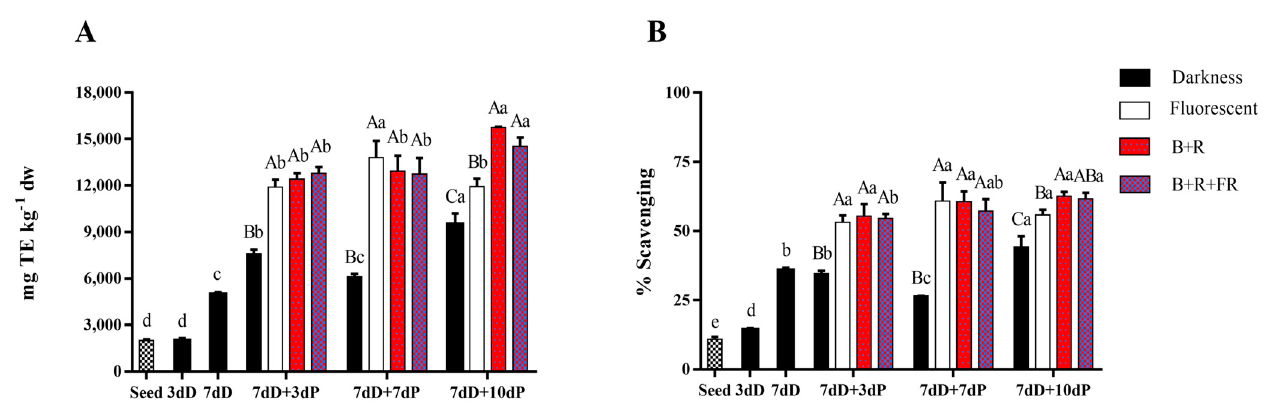
Figure 5. Total antioxidant capacity index ( A ) and total scavenging activity Index ( B ) of carrot sprouts grown at 20 °C during 7 days in darkness (dD) +3 or 7 or 10 days of a 16 h/8 h photoperiod (dP) under several light treatments. B+R: Blue+Red; B+R+FR: Blue+Red+Far-Red LEDs. Different capital letters indicate significant differences among treatments at p < 0.05 based on Tukey’s test. Different lowercase letters indicate significant differences among time of analysis of the same treatment at p < 0.05 based on Tukey’s test.